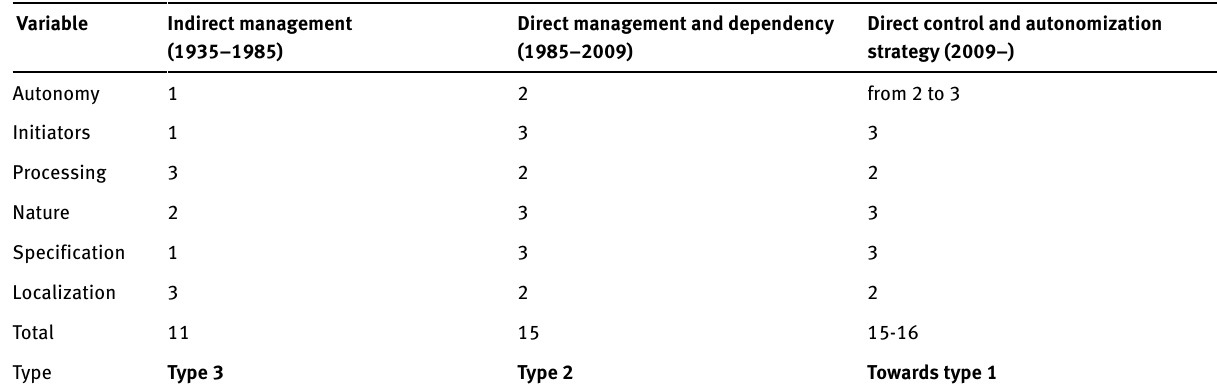
Table 4: Trajectory of the Entremonts cooperative